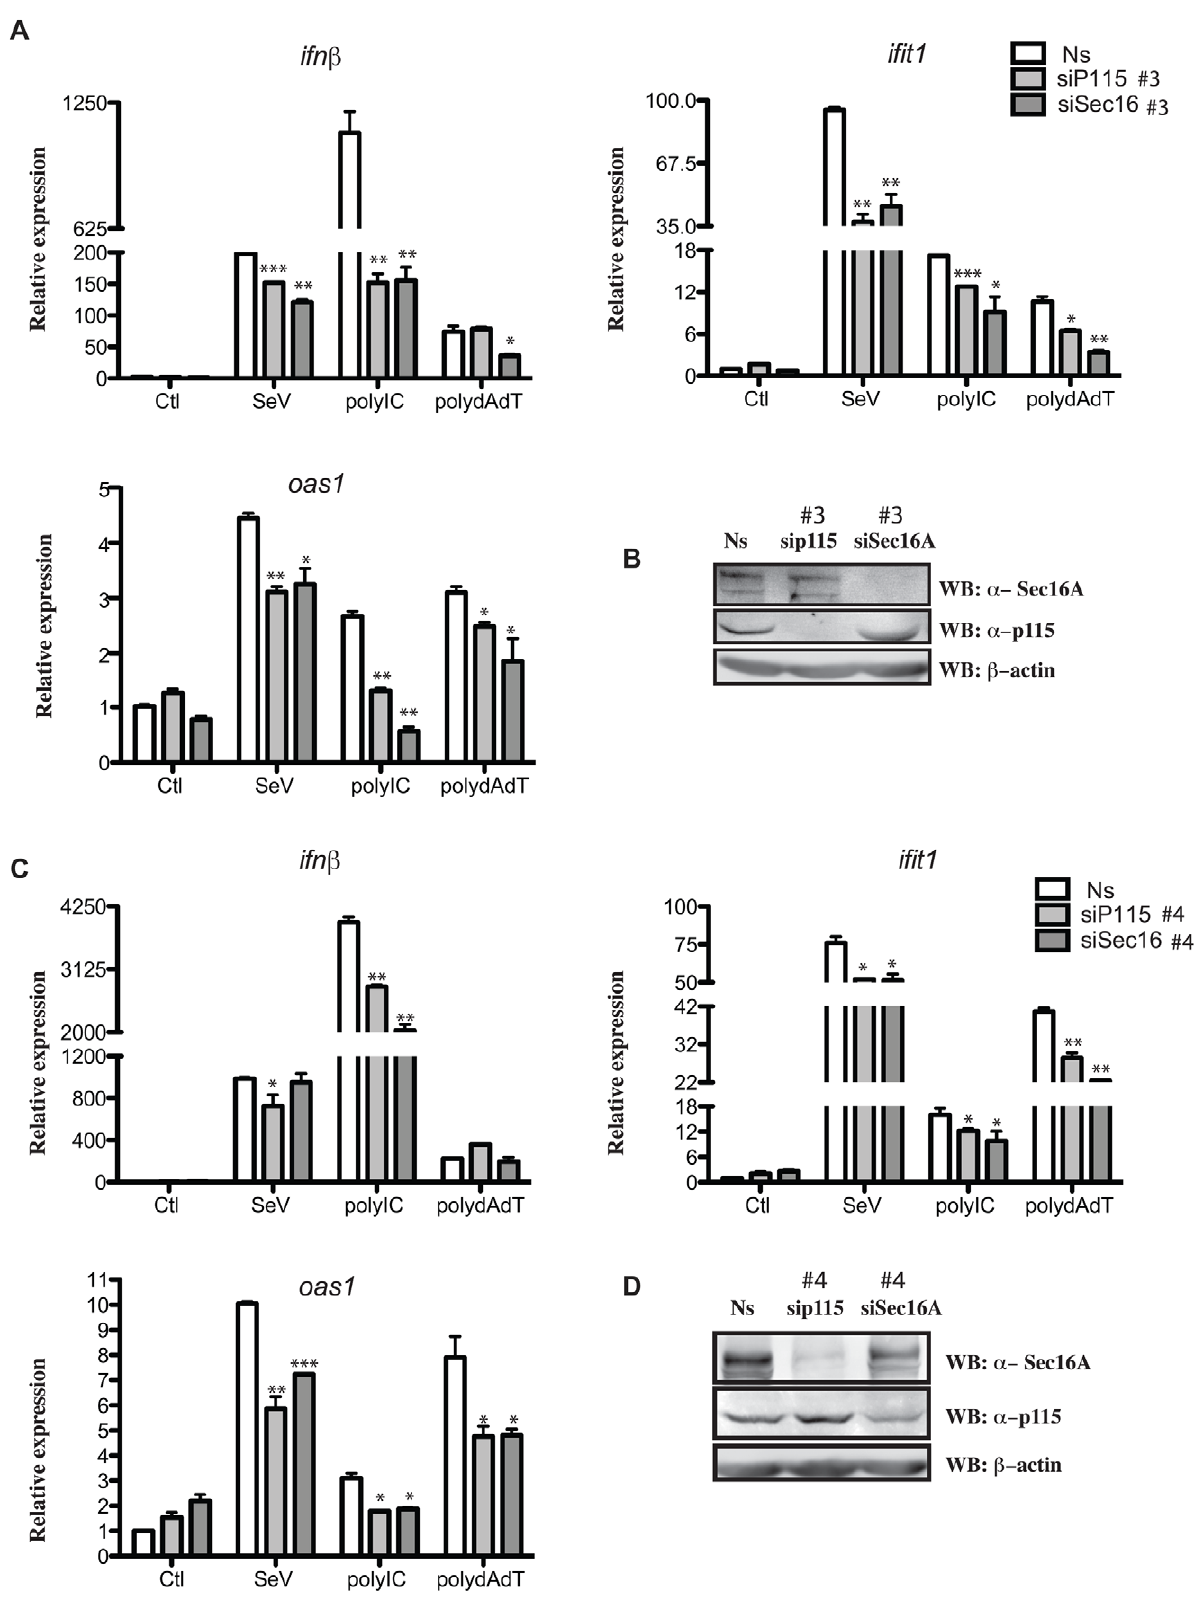
Figure 9. Requirement of Sec16A and p115 for optimal type I IFN innate immune response in cells exposed to cytosolic DNA and RNA sensor ligands. ( A–D ) HeLa cells were transfected with nonsilencing (Ns) RNA duplexes or two different sets of siRNA duplexes that specifically target p115 or Sec16A as indicated. 72 h post-transfection, cells were left untreated (Ctl) or stimulated with poly I:C (2.5 m g/ml), poly